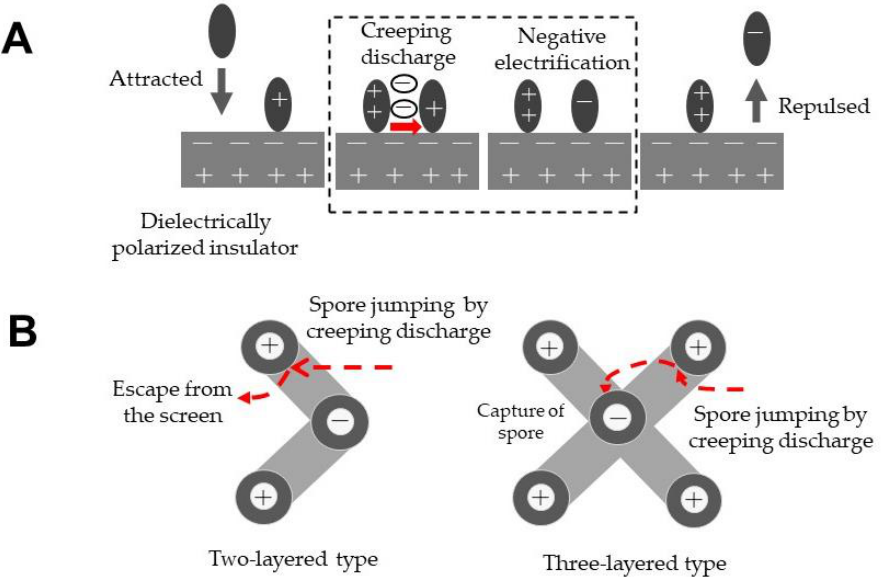
Figure 7. ( A ) Schematic representation of creeping discharge between two spores and spore jump- ing on the electrified insulator covering a charged conductor; and ( B ) schematic representation of the escape (left) and recapture (right) of a jumping spore in two- and three-layer electric field screens, respectively.